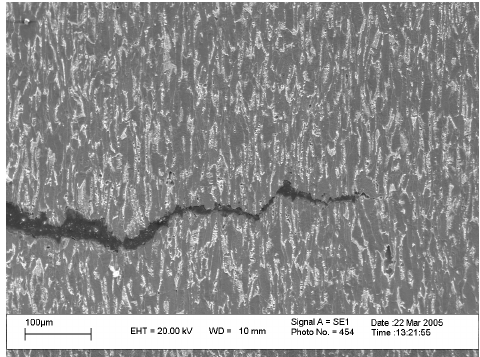
Figure 12: Fracture path under Microscope. Figure 13: Grain in front of crack tip.